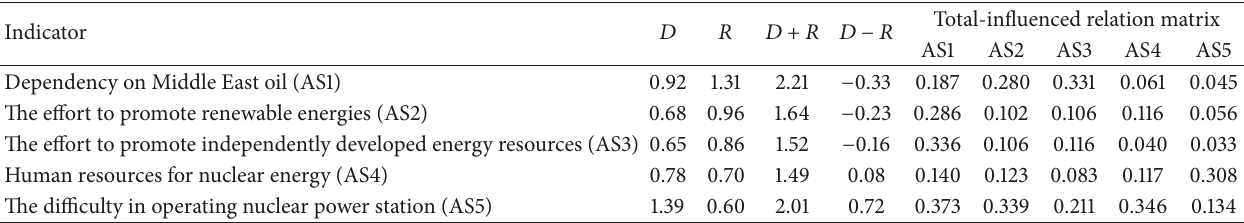
Table 12: The result of Fuzzy-DEMATEL analysis for Accessibility (Case 2 ).